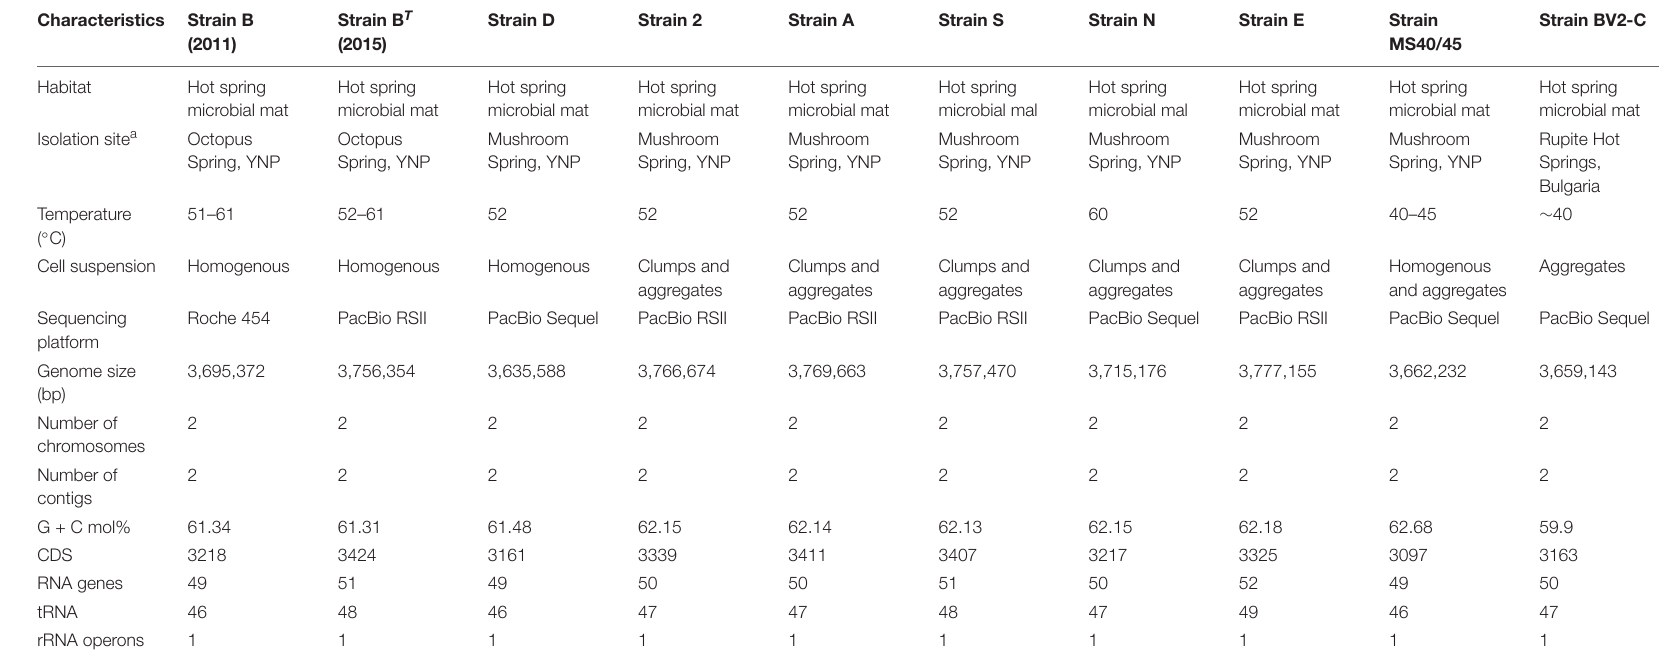
TABLE 1 | General information concerning ten strains of Chloracidobacterium spp. Characteristics Strain B